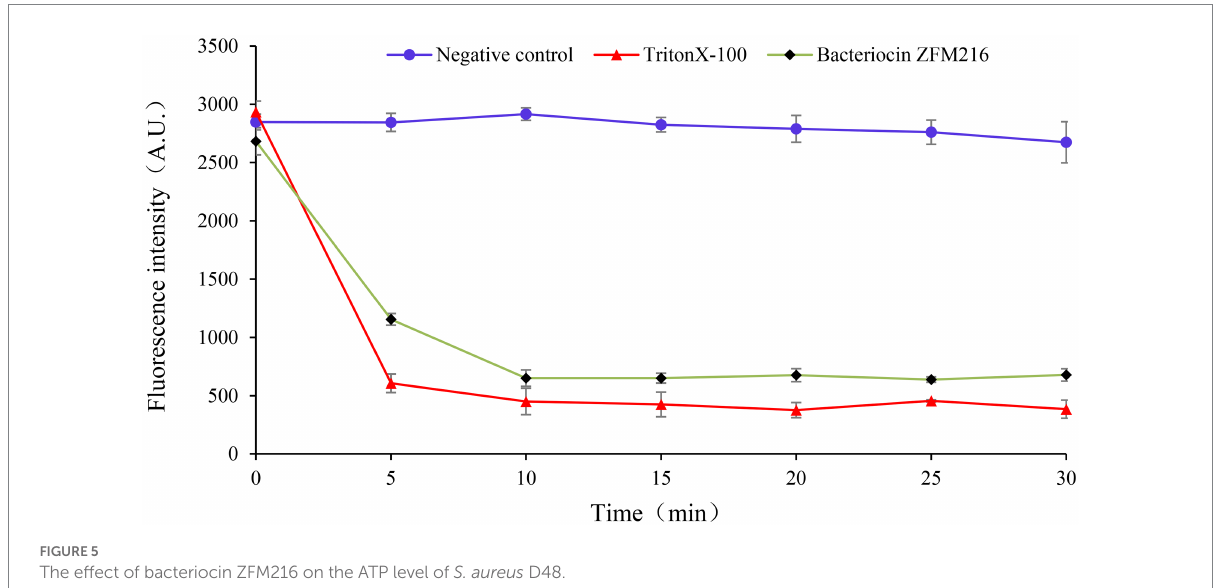
FIGURE 5 The effect of bacteriocin ZFM216 on the ATP level of S. aureus D48.